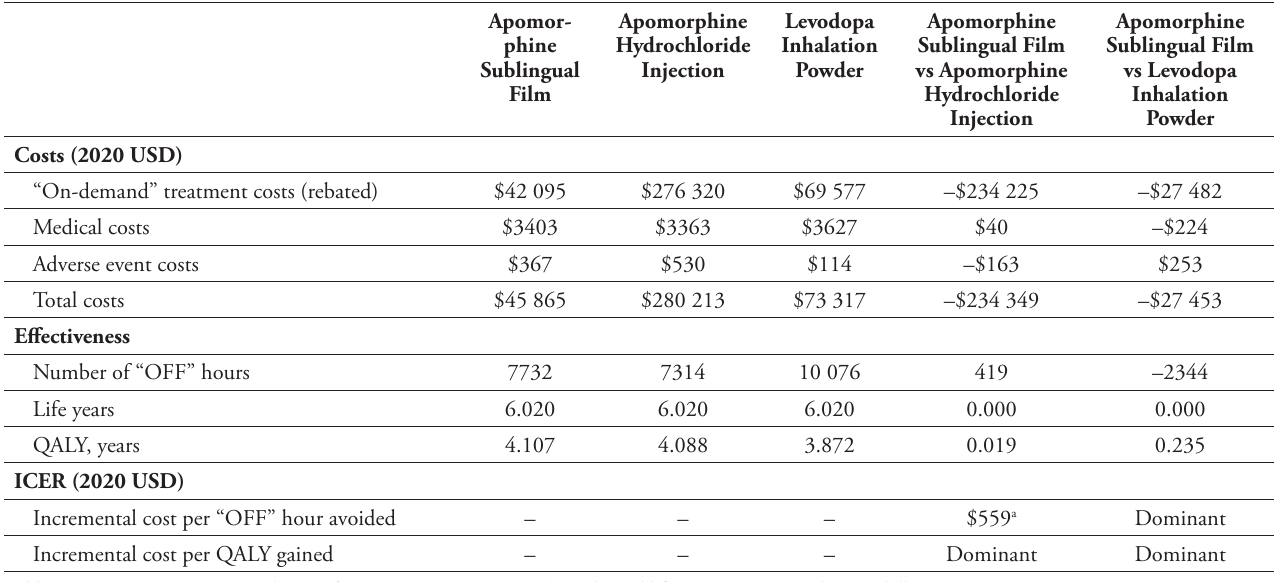
Table 3. Base-Case Results of the